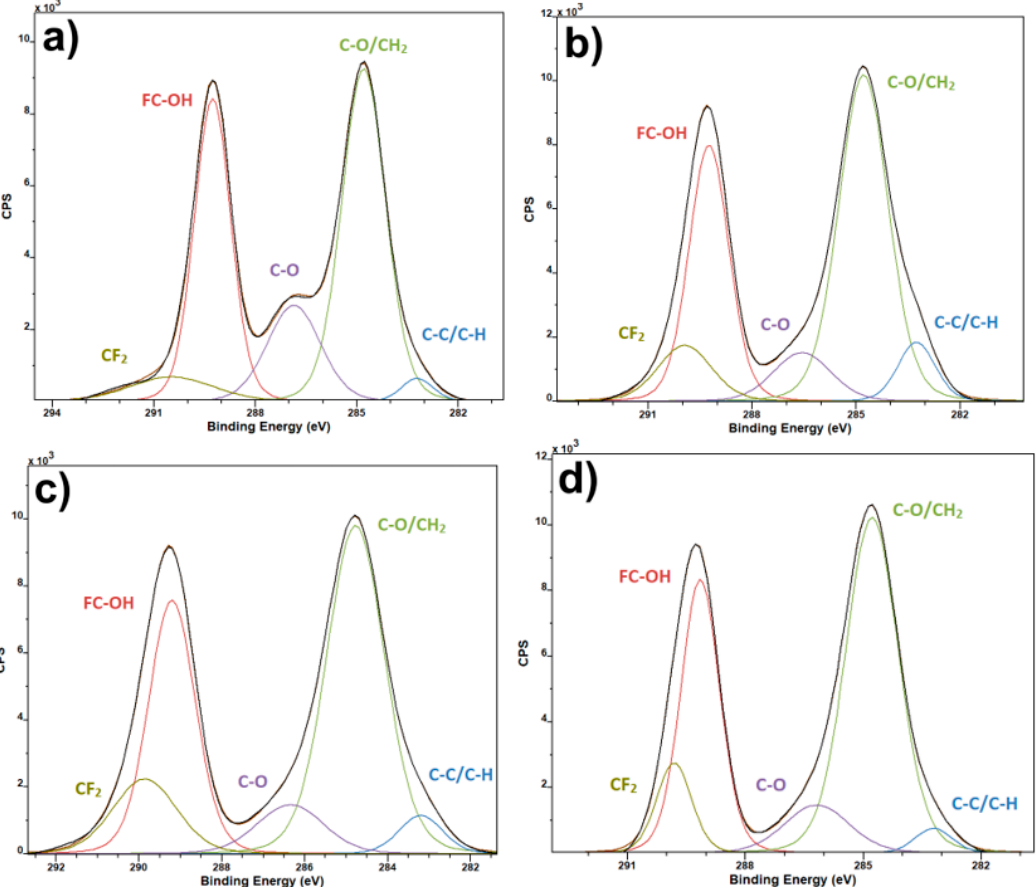
Figure 1. XPS C1 spectra of pure PVDF fibers ( a ) and PVDF fibers with Ca(NO 3 ) 2 ( b ), Mg(NO 3 ) 2 ( c ) and Zn(NO 3 ) 2 ( d ).